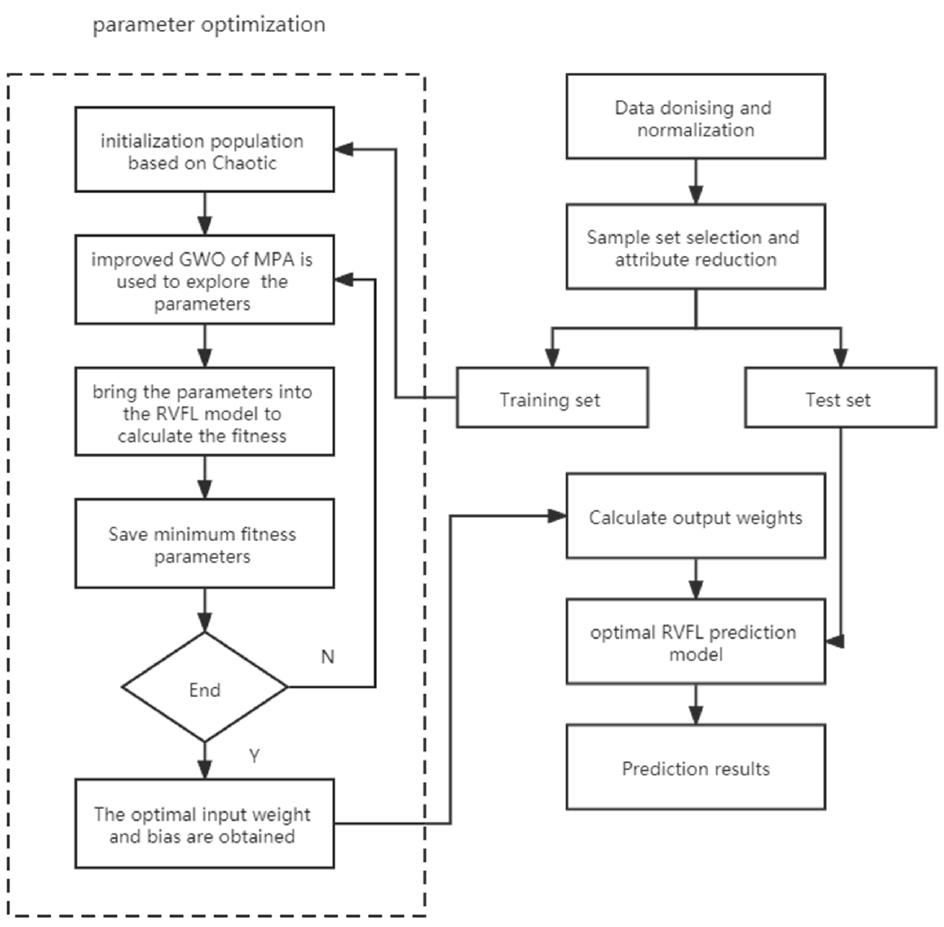
Figure 4. MPA-GWO-RVFL Oil layer prediction model.